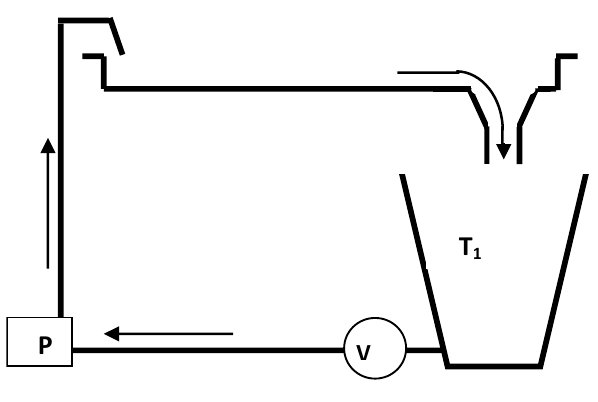
Fig. 2. Open plate (1,000 L) for outdoor sub-culture. T=